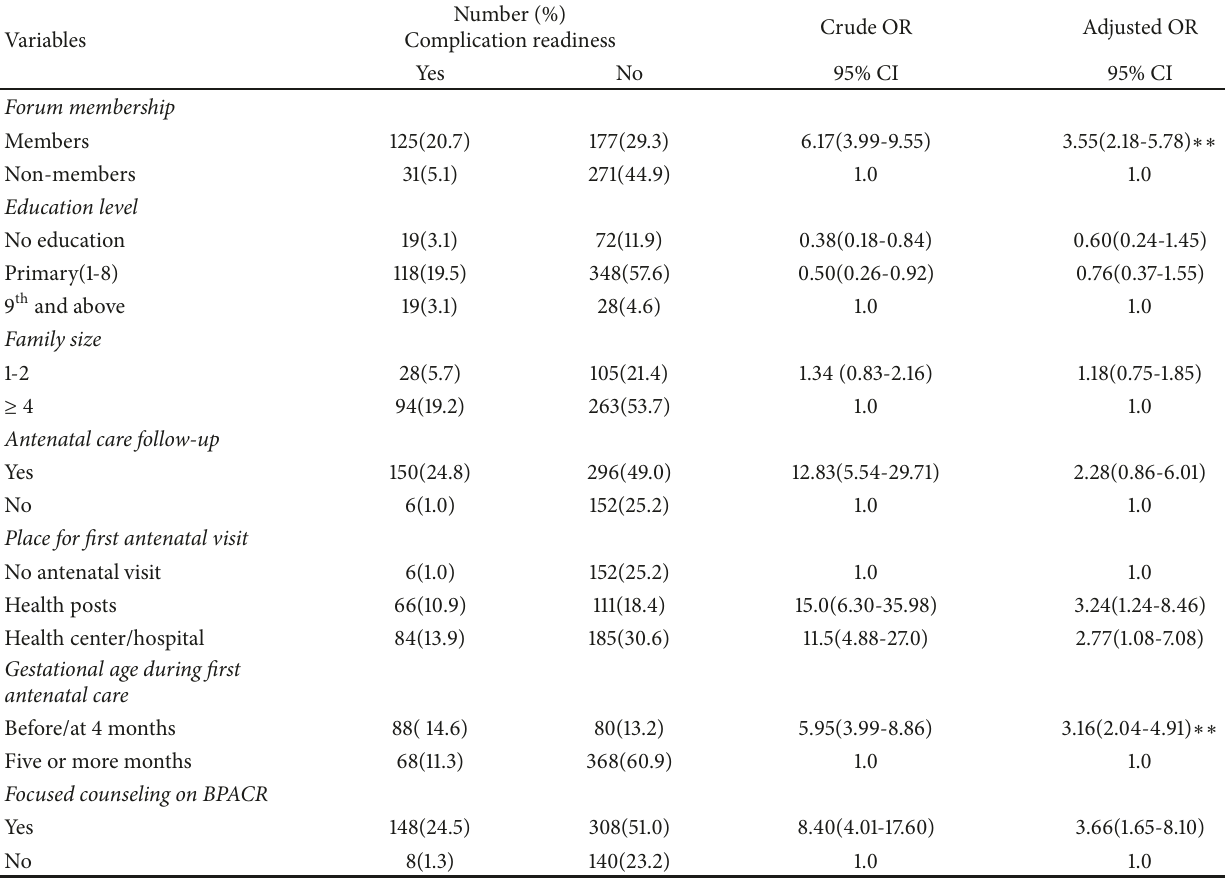
Table 7: Selected characteristics influencing the complication readiness among pregnant women in Dale District, Sidama Zone, SNNPR, 2015